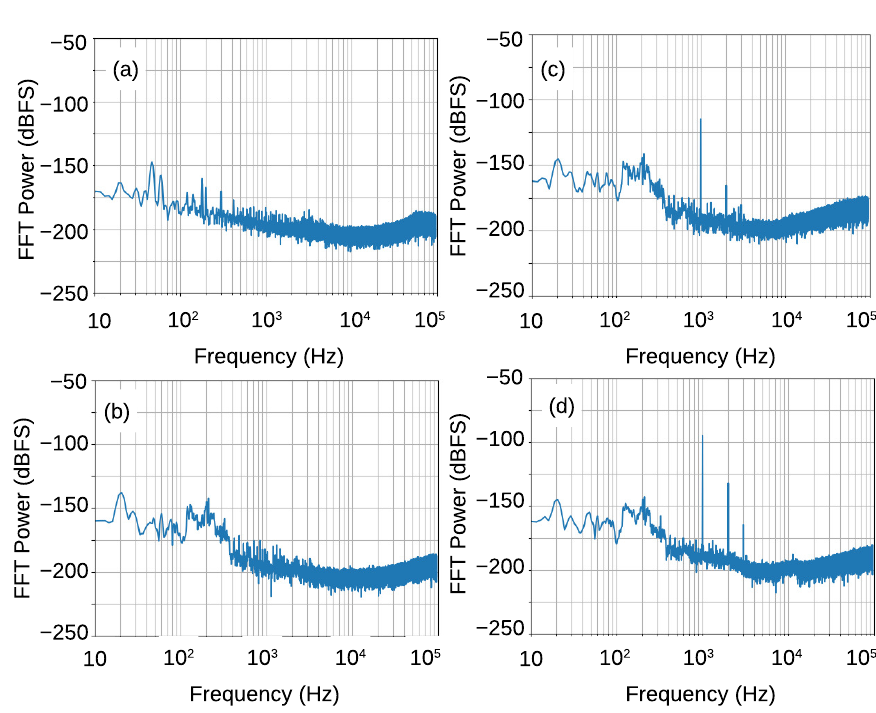
Figure 18. Sound spectra from the FDSM microphone sensors. ( a ) Covered by 5 mm Copper plate in place of the calibrator, ( b ) No sound signal, ( c ) under 1 kHz, 94 dBSPL sound signal, ( d ) under 1 kHz 114 dBSPL sound signal. The FFT results were averaged for three data